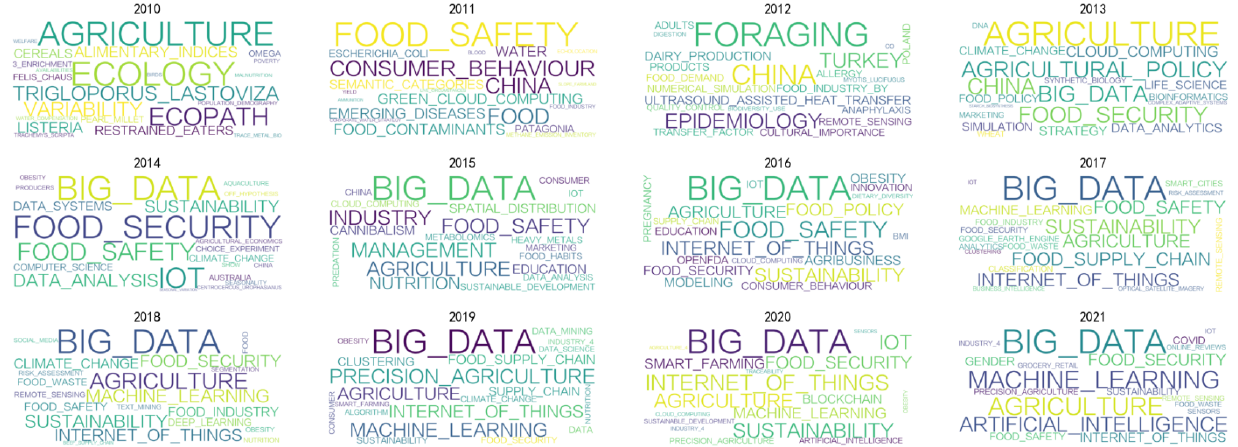
Figure 2. Analysis of the research direction of the data from 2010 to 2021 in the food field. Since 2013, food security and big data have become a focus of researchers interested in the potential value of big data on food. The research focuses on IoT-based data collection and its application to smart farming, supply chain management, food nutrition, and sustainable